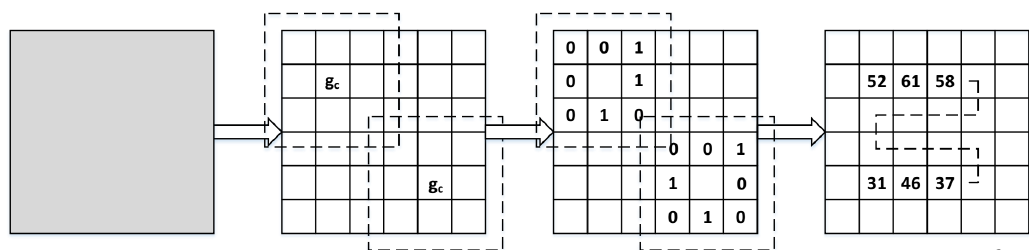
Figure 7. Binarization process of the MB-LBP.